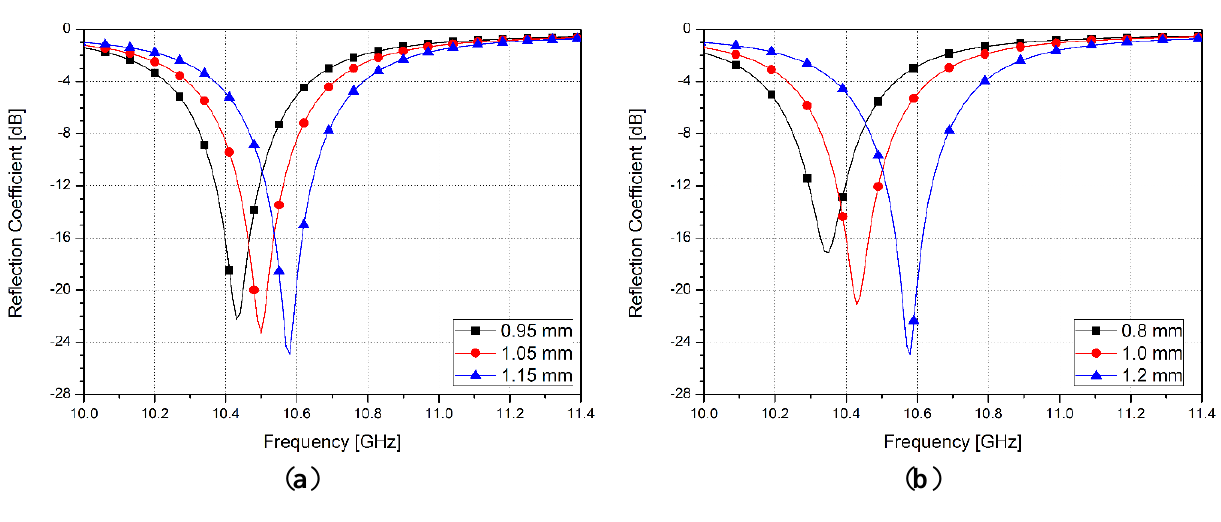
Figure 4. Simulated reflection coefficients of different length of ( a ) f and ( b ) h